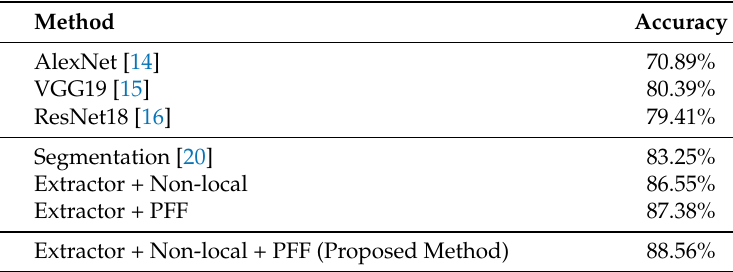
Table 1. Comparison results of the proposed